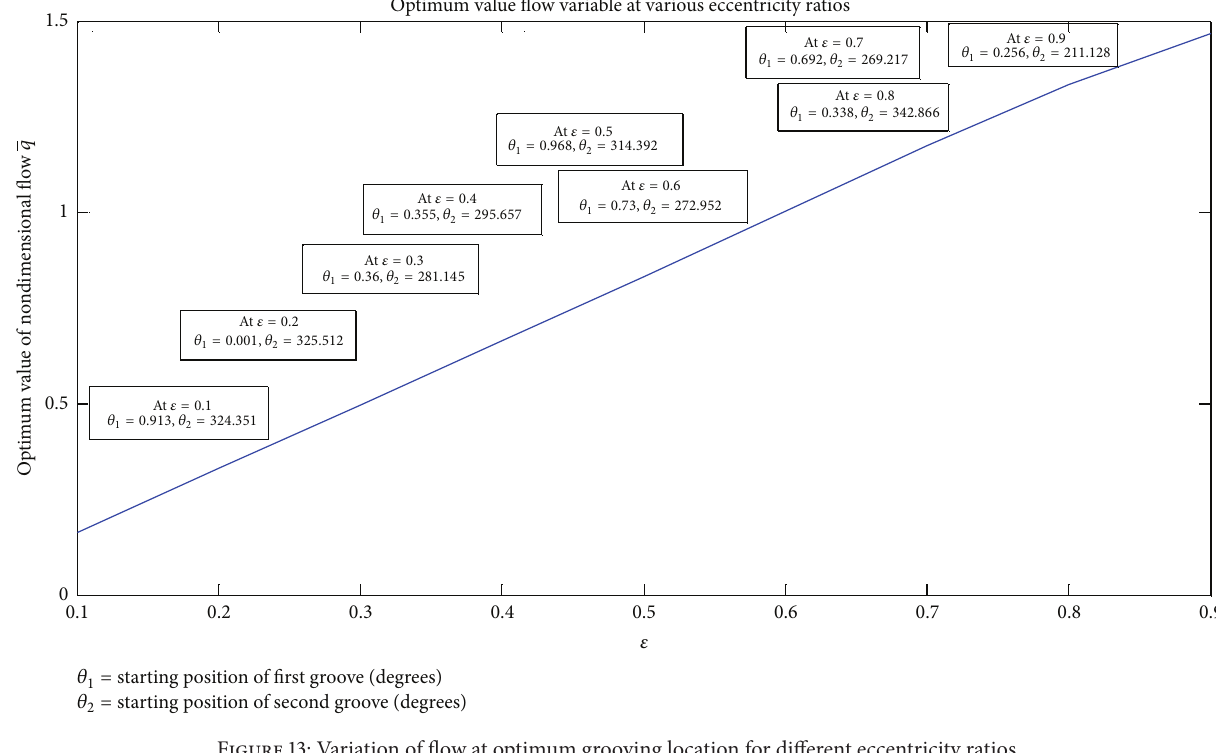
Figure 13: Variation of flow at optimum grooving location for different eccentricity ratios.